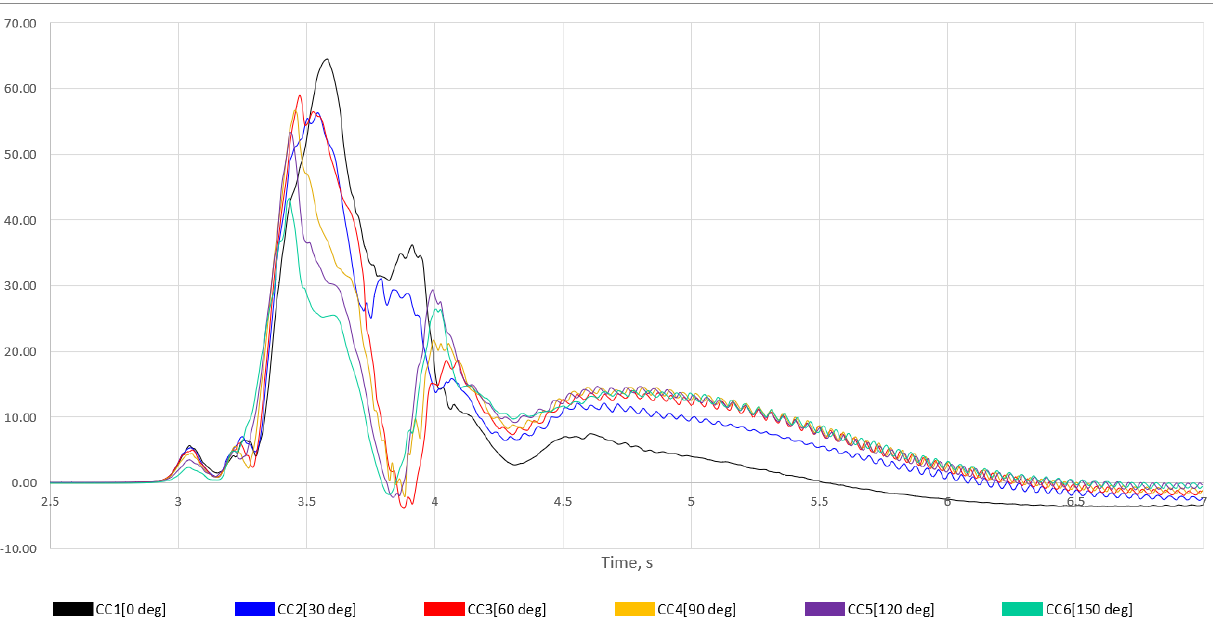
The instantaneous power curves are obtained using the instantaneous torque and angular velocity from simulation monitors and applying the method stated in Section 2.4.